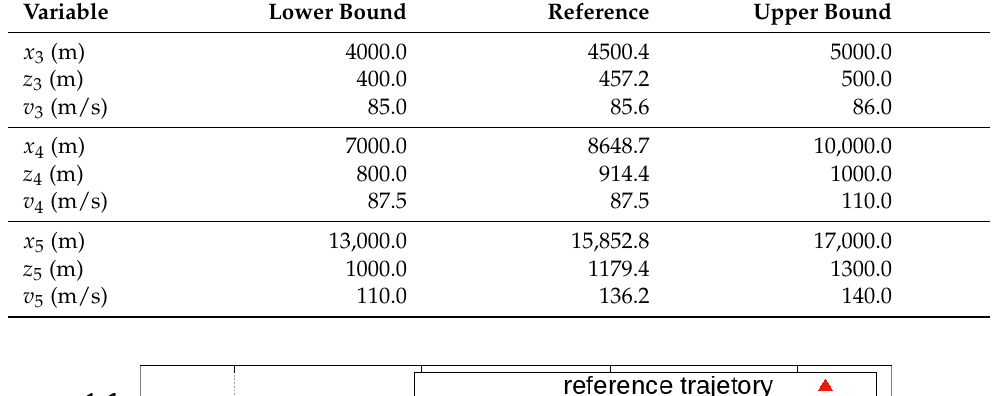
Table 4. Takeoff manoeuvre optimisation variables for the single-aisle aircraft: reference values with upper and lower bounds.